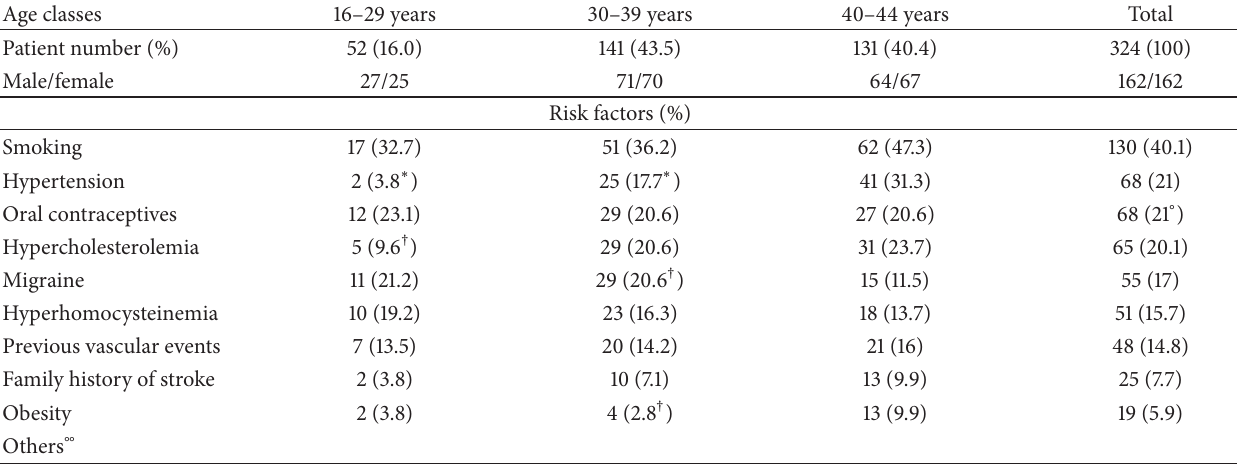
Table 1: Baseline characteristics and risk factors stratified by age